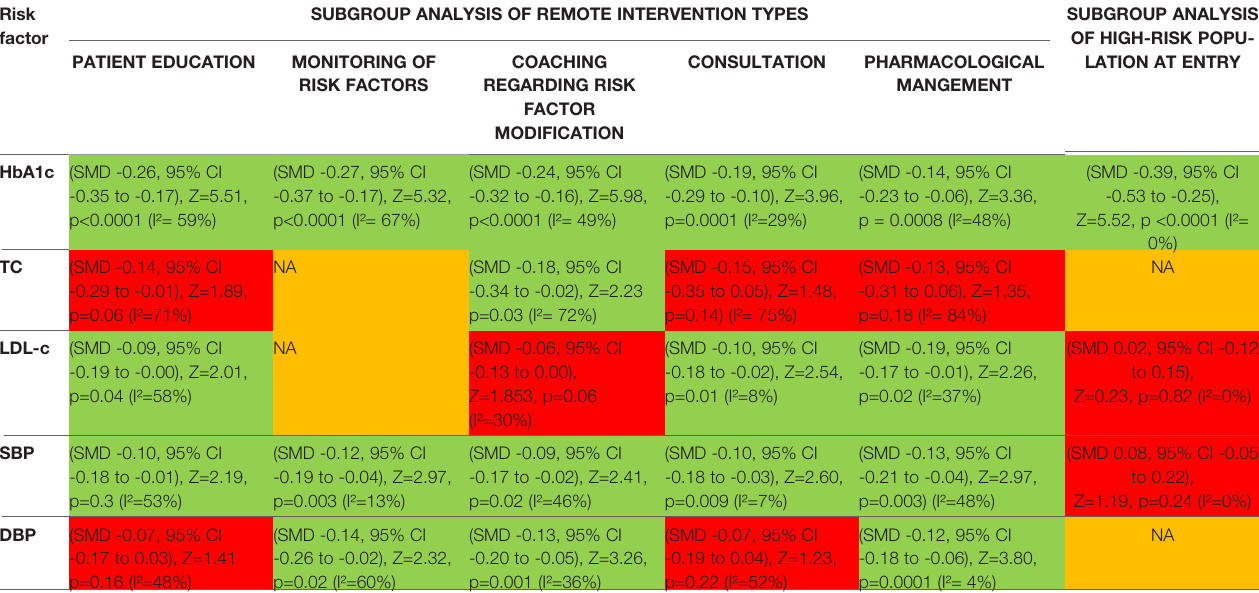
TABLE 2 | Meta-analysis outcomes by subgroups of remote interventions and high-risk